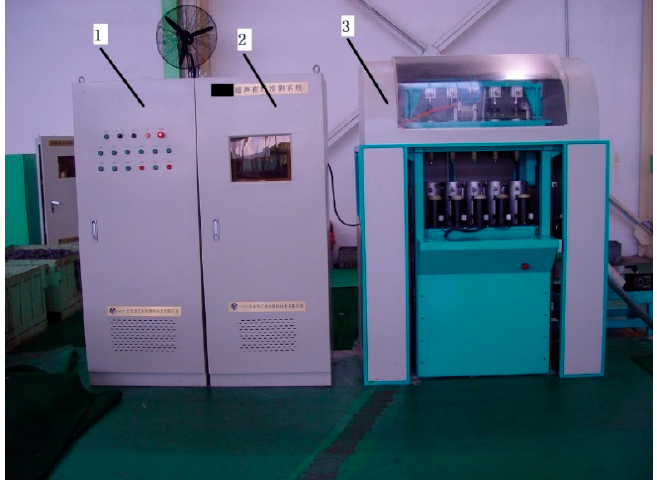
Figure 5. Appearance of testing equipment (1. PLC control unit; 2. PC control unit; 3. mechanical device).